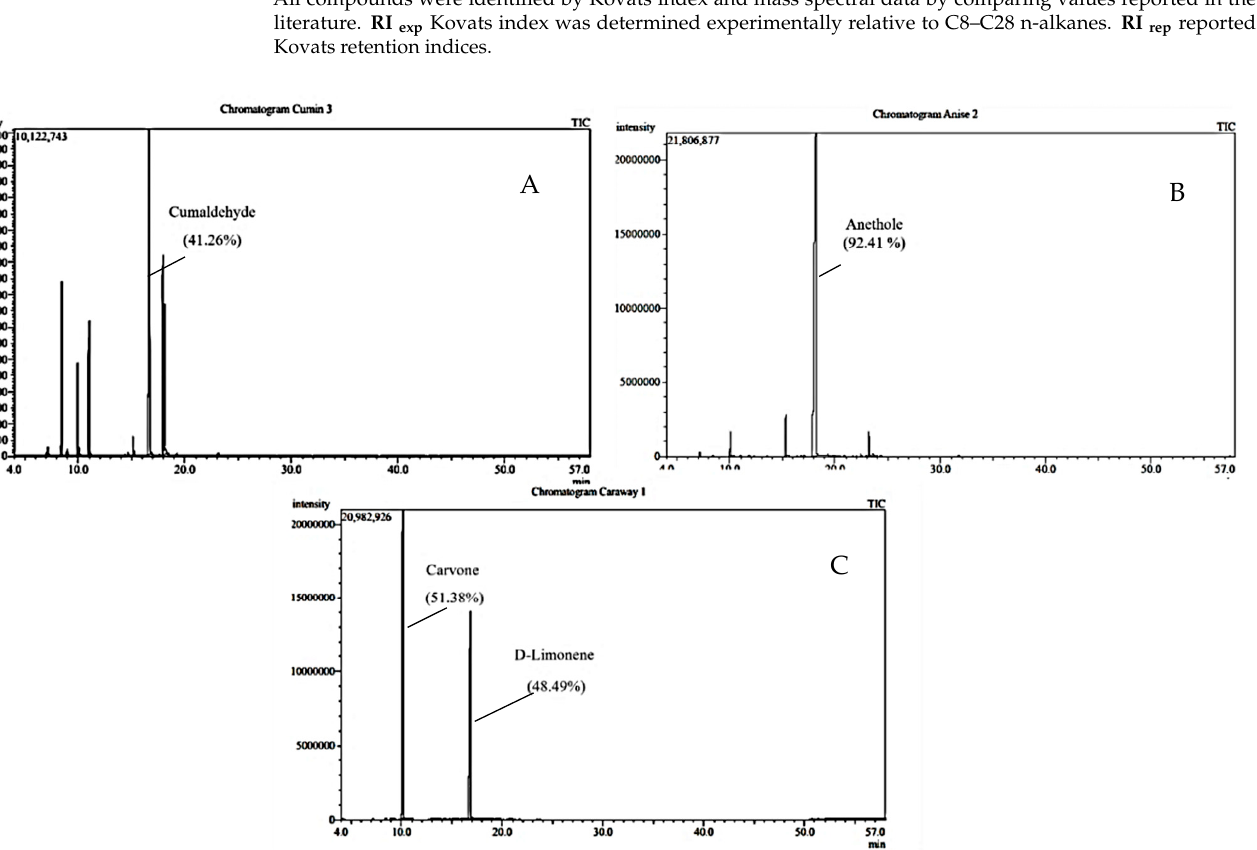
Figure 1. GC chromatograms of the essential oils of ( A ) C. cyminum , ( B ) P. anisum, and ( C ) C. carvi.